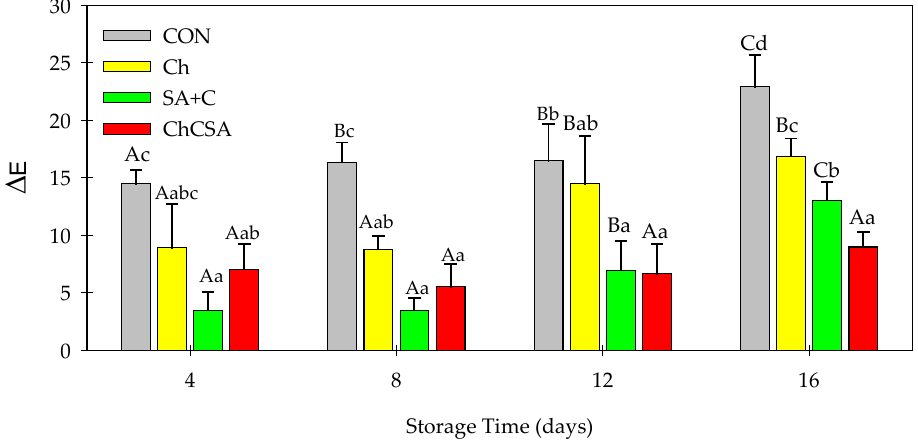
Figure 1. The effect of single-layer and gel coatings on the changes in total color difference value ( ∆ E) of fresh-cut purple sweet potatoes. Vertical bars represent means and standard deviation. Bars with different alphabets within the same storage day (lower case) or same treatment group at different storage days (upper case) are significantly different (Tukey’s HSD Test, p ≤ 0.05).